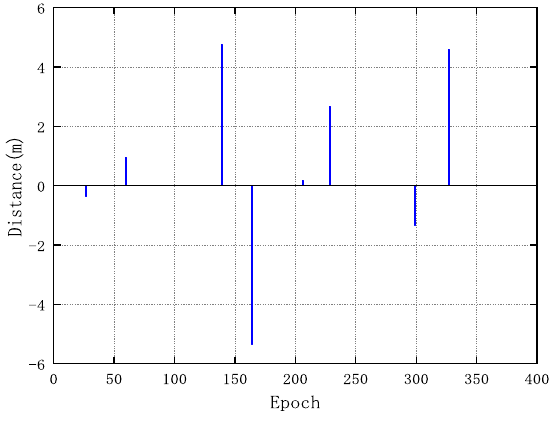
Figure 8. The fourth case, when the cycle slip occurs simultaneously on two frequencies, the results obtained by the proposed indoor dual-frequency cycle slip detection method.